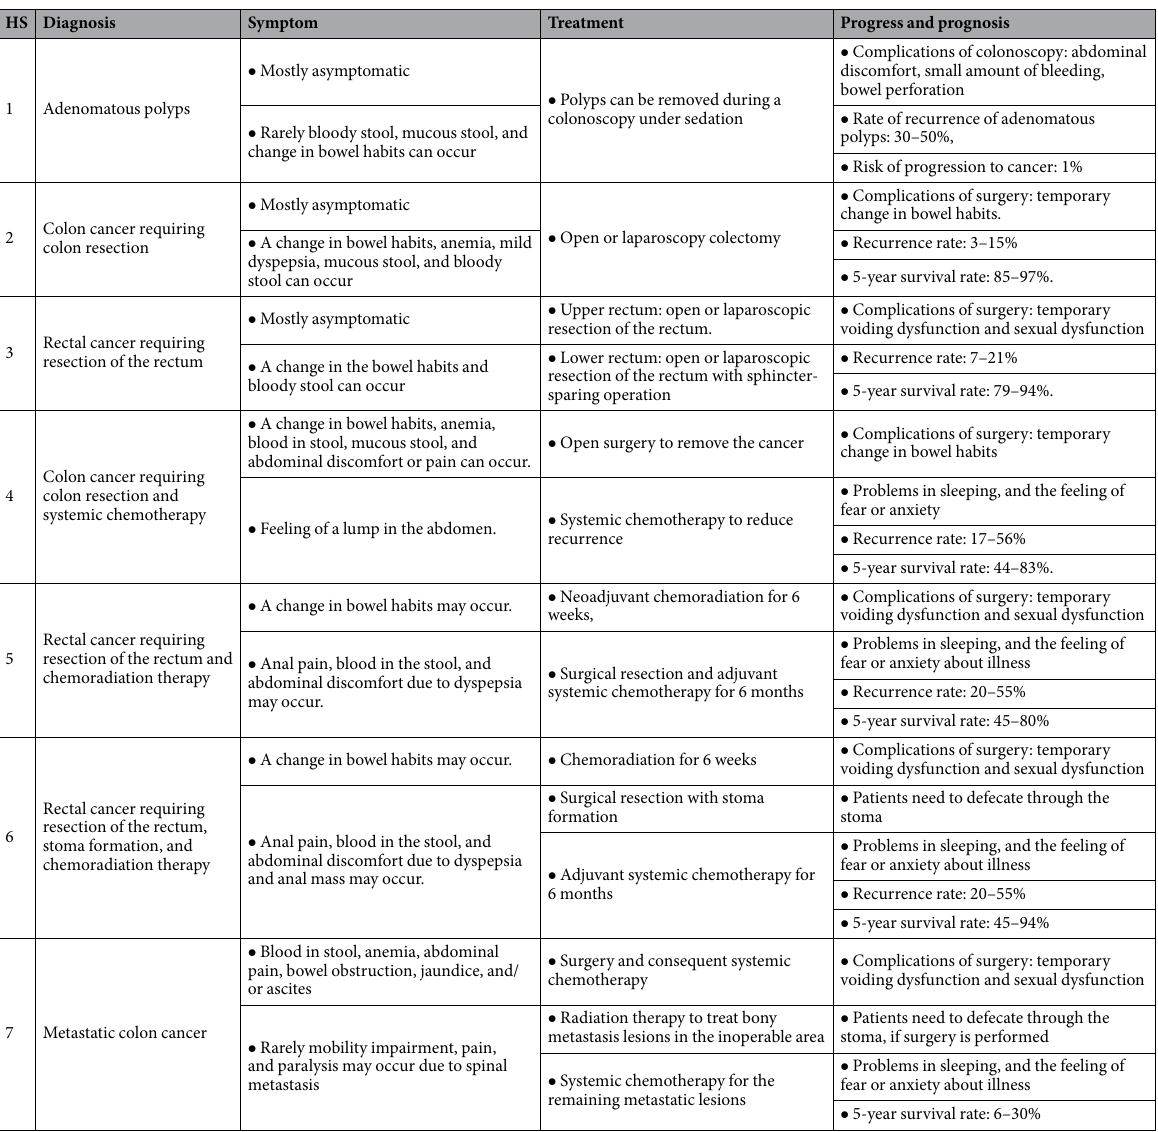
Table 4. Description of the health states associated with colorectal cancer. HS: health